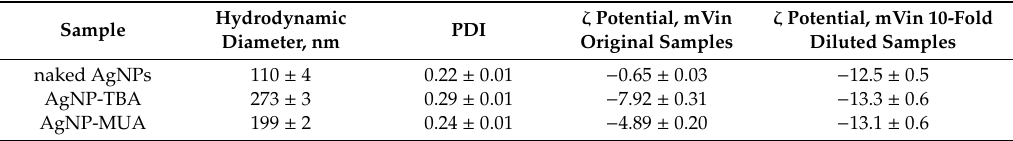
Table 2. Hydrodynamic diameter, polydispersity index (PDI), and ζ potential value measured for synthesized AgNPs